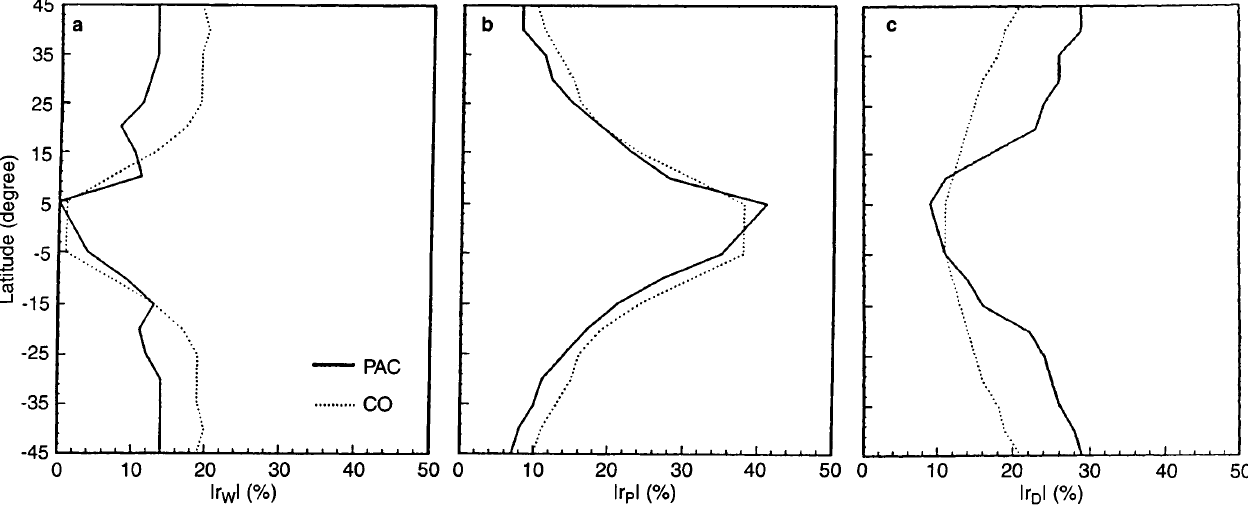
Fig. 3a–c. Linear energy flux coe(cid:129)cients (%) at di(cid:128)erent latitudes (degree). a r meridional boundary ( C0 ). Wave period: 180